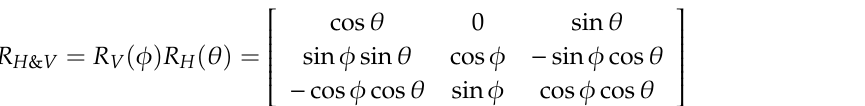
Figure 4. ( a ) Top view of the eye coordinate frame plane P iris and the image plane P img are assumed to be parallel. The initial iris e ref is detected in the eye image and it is centered at p ref ; ( b ) the iris plane is rotated by R ref → curr . The initial iris e ref is projected from the rotated iris plane P iris onto the image plane P img , giving e curr